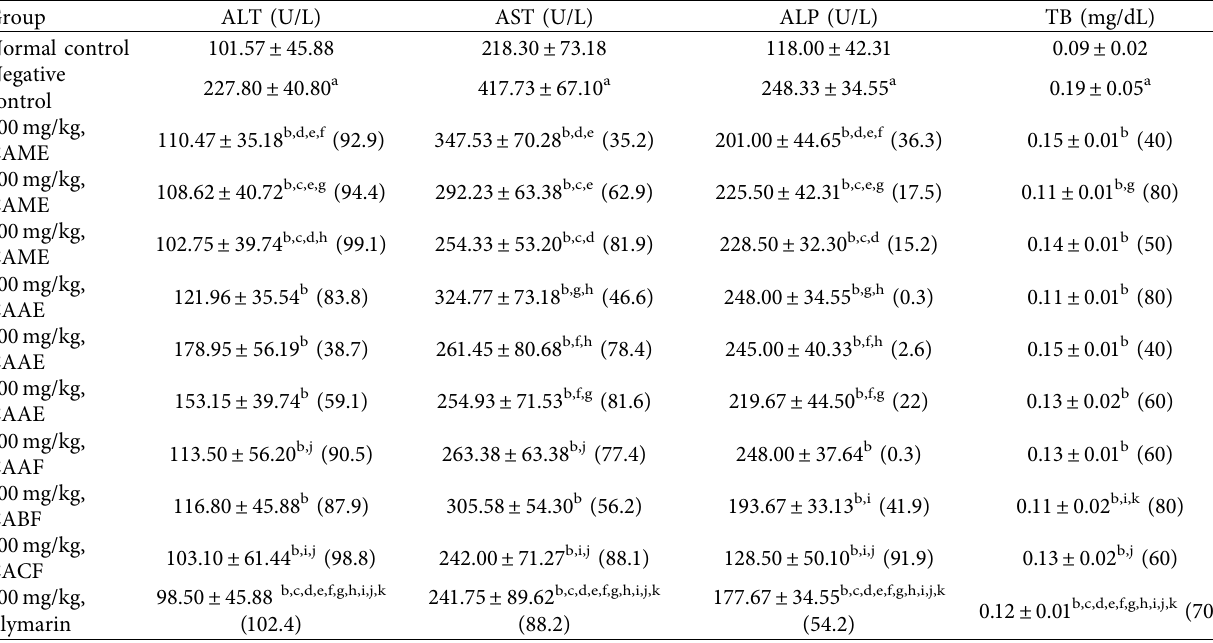
Table 2: Effects of crude extracts and solvent fractions of the 80% methanol extract of C. africana stem bark on serum levels of the liver enzymes and TB of rats orally administered 2 g/kg APAP (mean ±